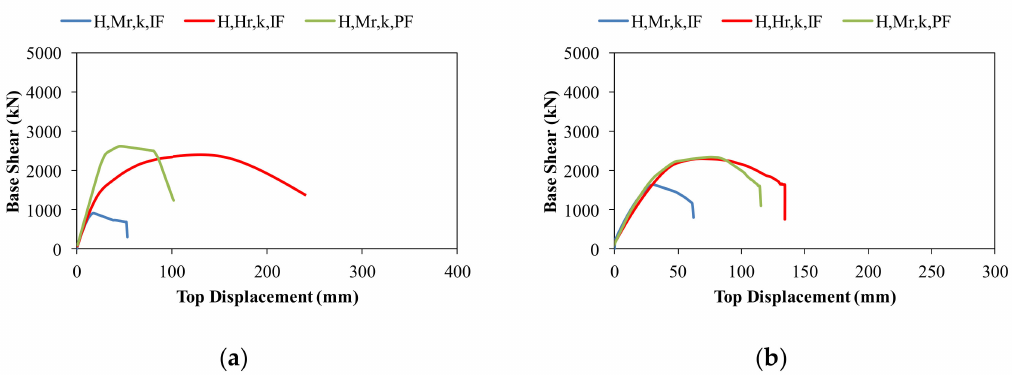
Figure 5. Pushover curves of the selected H-archetype buildings in ( a ) X-direction and ( b ) Y-direction.